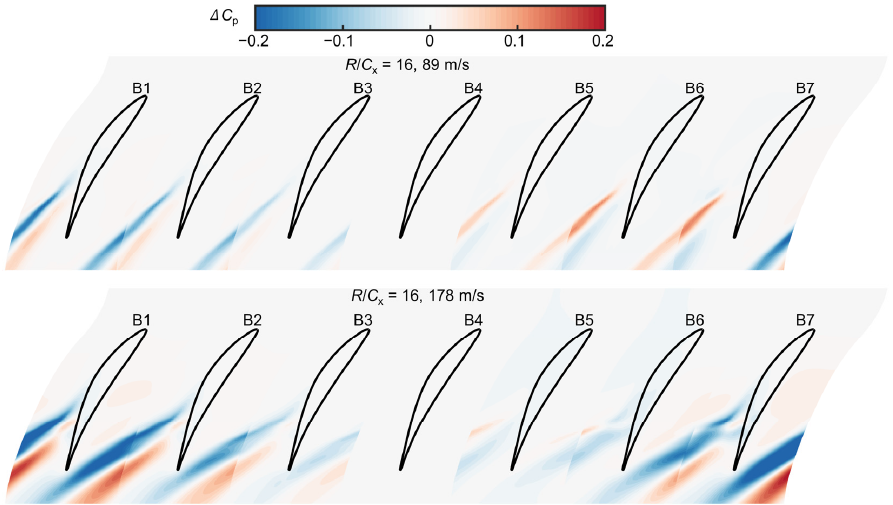
Figure 13. Endwall static pressure coefficient difference at different pitch locations.